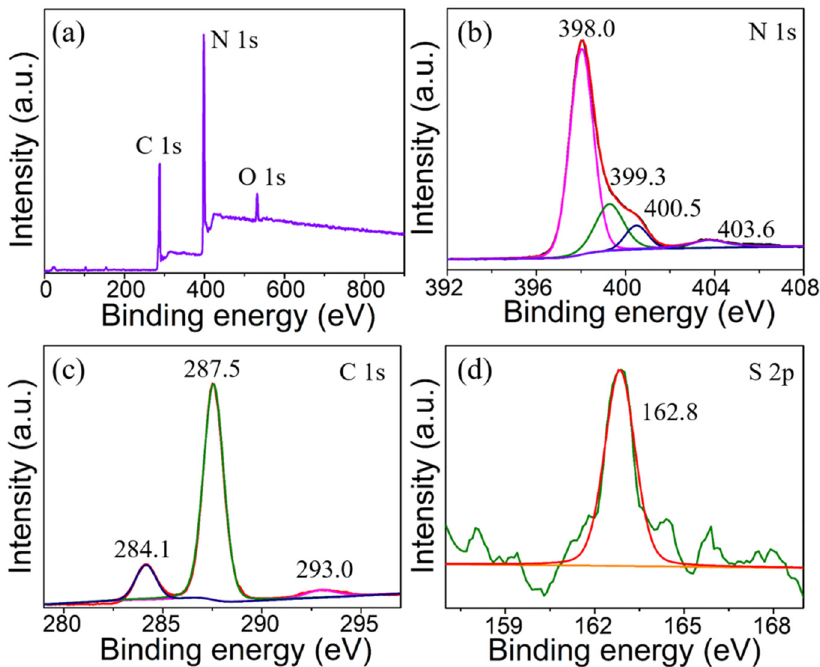
Figure 2: (a) XPS spectrum of the